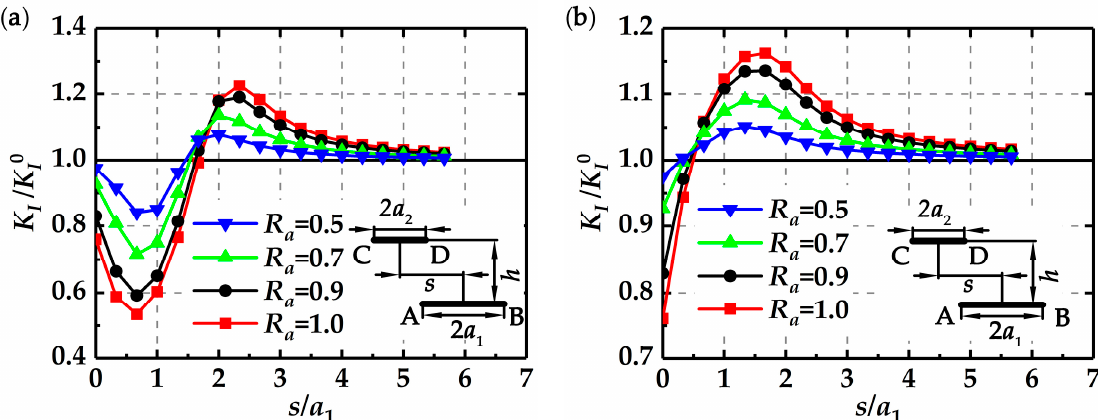
Figure 6. Changes of K I / K I0 with s / a 1 at h = 2.5 mm for different R a : ( a ) K I / K I0 at tip A, and ( b ) K I / K I0 at tip B.